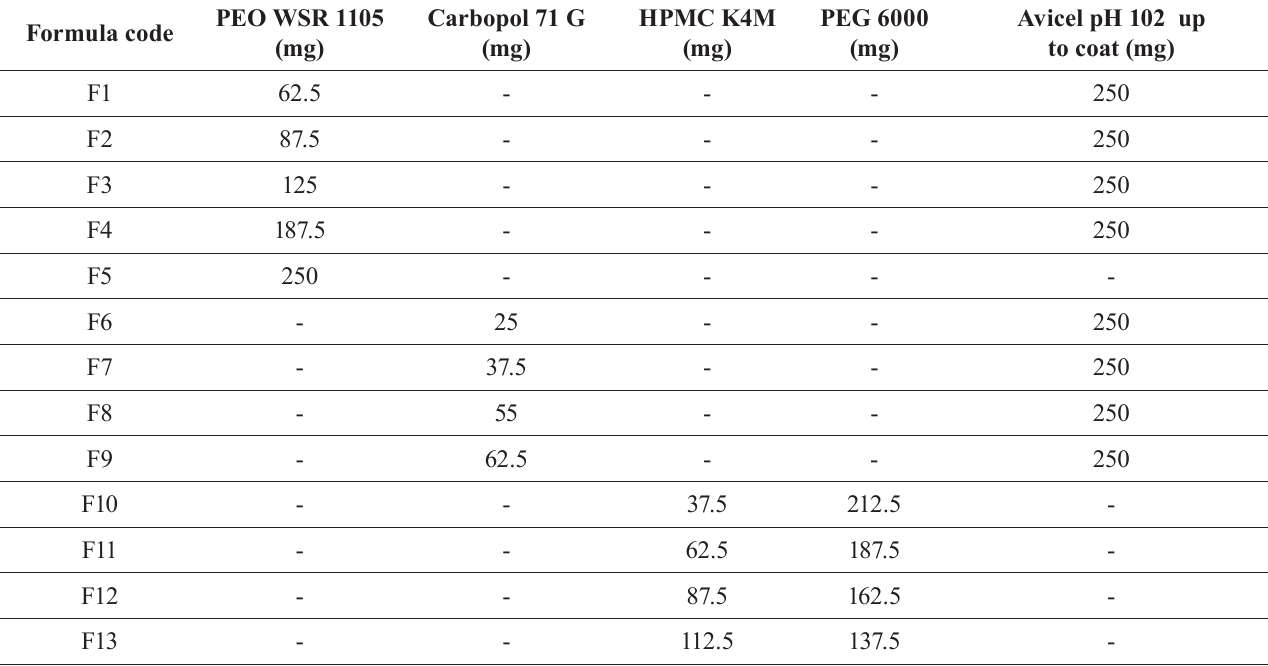
TABLE I - S uggested composition of the coating layer